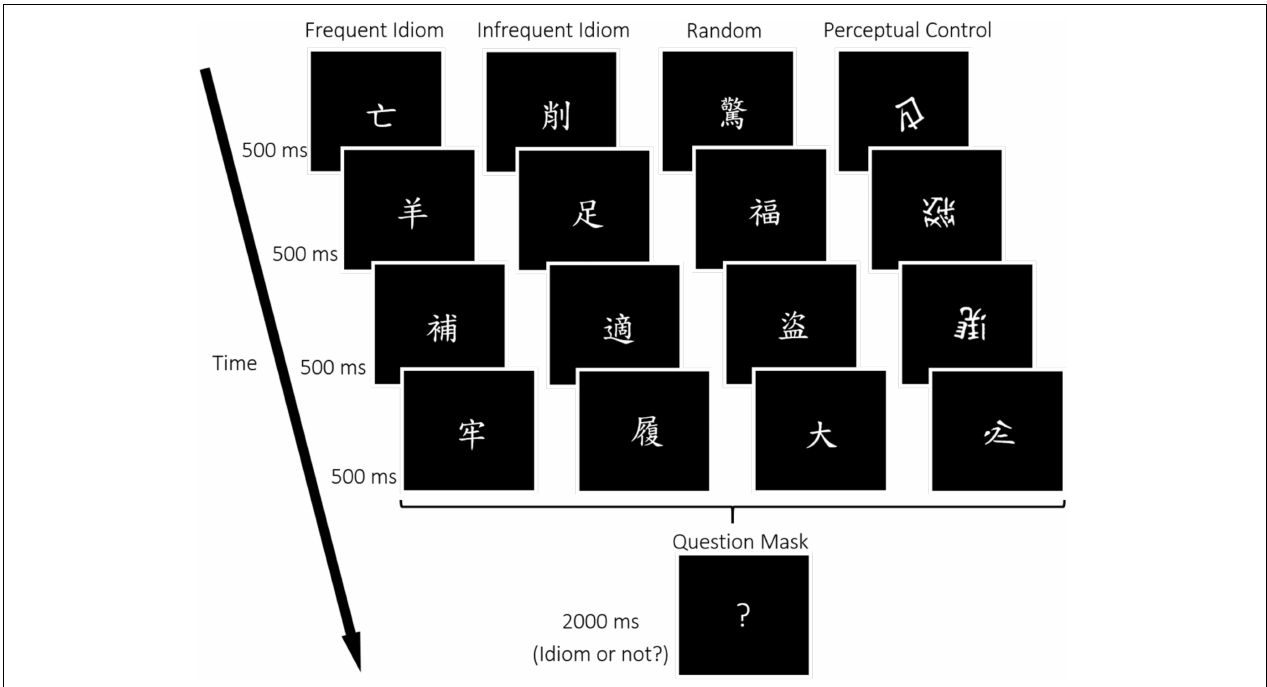
FIGURE 1 | Sample experimental stimuli of the idiom judgment task. Four conditions were used for the target phase in this study, including Frequent Idiom (e.g., “ ” is translated as “When the sheep run away, then you mend the sheepfold,” and means “To figure out a way to remedy the problem and prevent further loss”), Infrequent Idiom (e.g., “ ” is translated as “Cut off a piece of your feet to fit the size of the shoe” and means “To have inflexible thinking”), Random (character sequences with no meaning), and Perceptual Control (non-word sequences). For each trial, the four-character stimuli were presented sequentially after which a response display containing a question mark appeared, during which participants responded whether the quartets constituted an idiom or not.